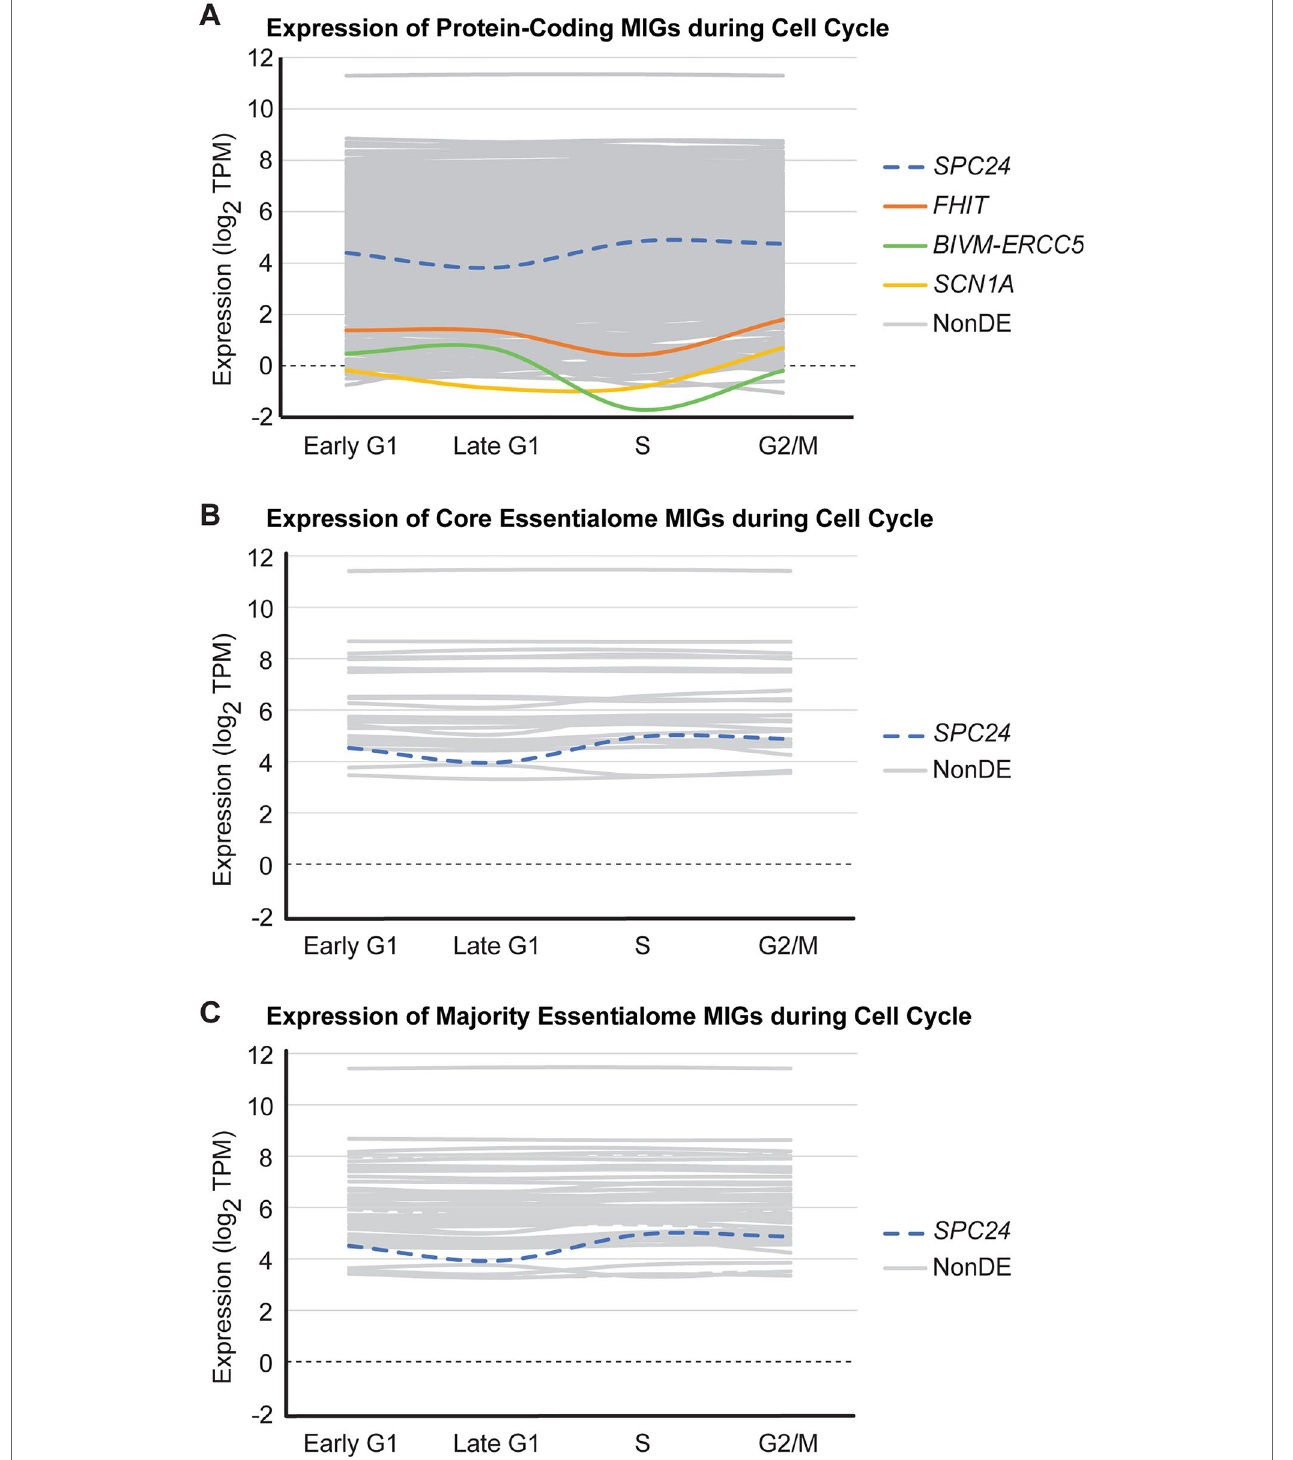
FIGUrE 5 | Most minor intron-containing genes (MIGs) are expressed stably during cell cycle. Data plotted for (A) 624 protein-coding MIGs, (B) 28 core essentialome MIGs, and ( C ) 63 majority essentialome MIGs deemed to be expressed during cell cycle (as determined by TPM≥1 in at least one stage of cell cycle). Data obtained from analysis of RNAseq generated by Singh et al. (2013). Each line represents the expression of one MIG throughout successive stages of cell cycle (early G1, late G1, S, and G2/M). Colored lines indicate MIGs that showed differential expression in at least one stage of cell cycle relative to the previous stage, gray lines are MIGs that are non-differentially expressed (NonDE) in all stages, and dashed lines represent MIGs in the younger essentialome.